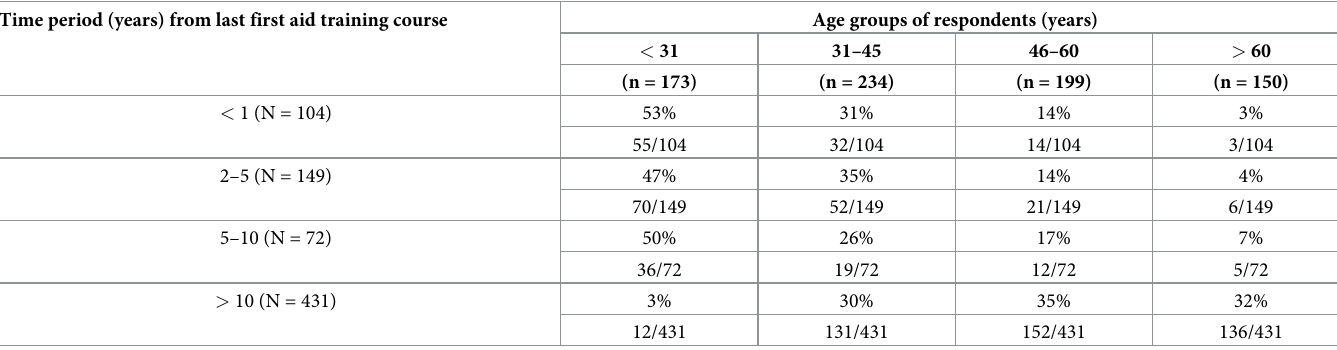
The shares (%) of respondents are shown by age groups in relation to the total number of respondents in individual time windows that have elapsed since the last first aid training. N—number of all in each time period; n–number of all per age